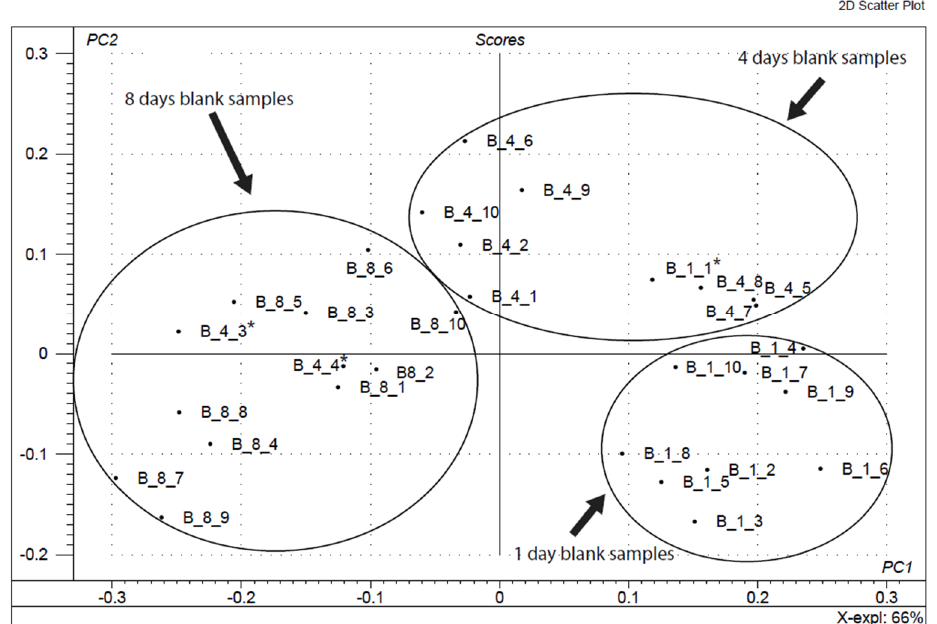
Figure 4. Oxidation pattern corresponding to all blank samples by means of principal component analysis (PCA).